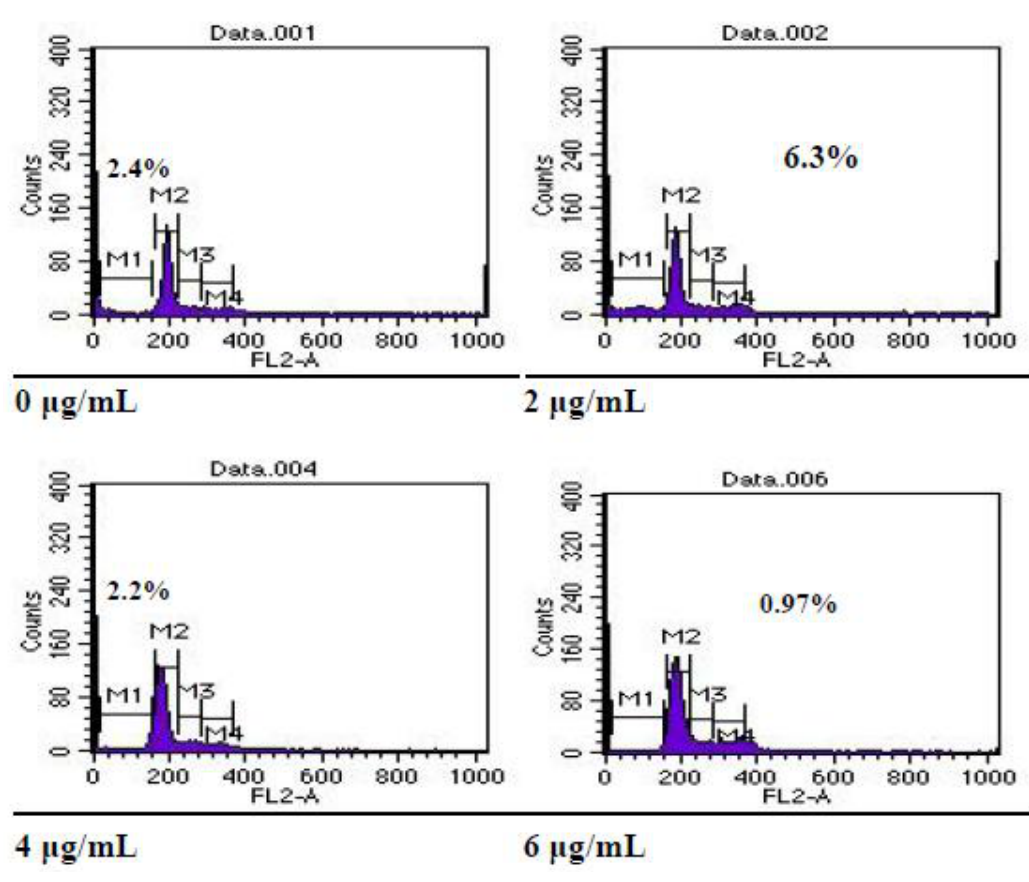
Figure 4. Representative cell cycle histograms of A549 cells treated with arsenic trioxide (0, 2, 4, and 6 µg/mL) for 48 h.